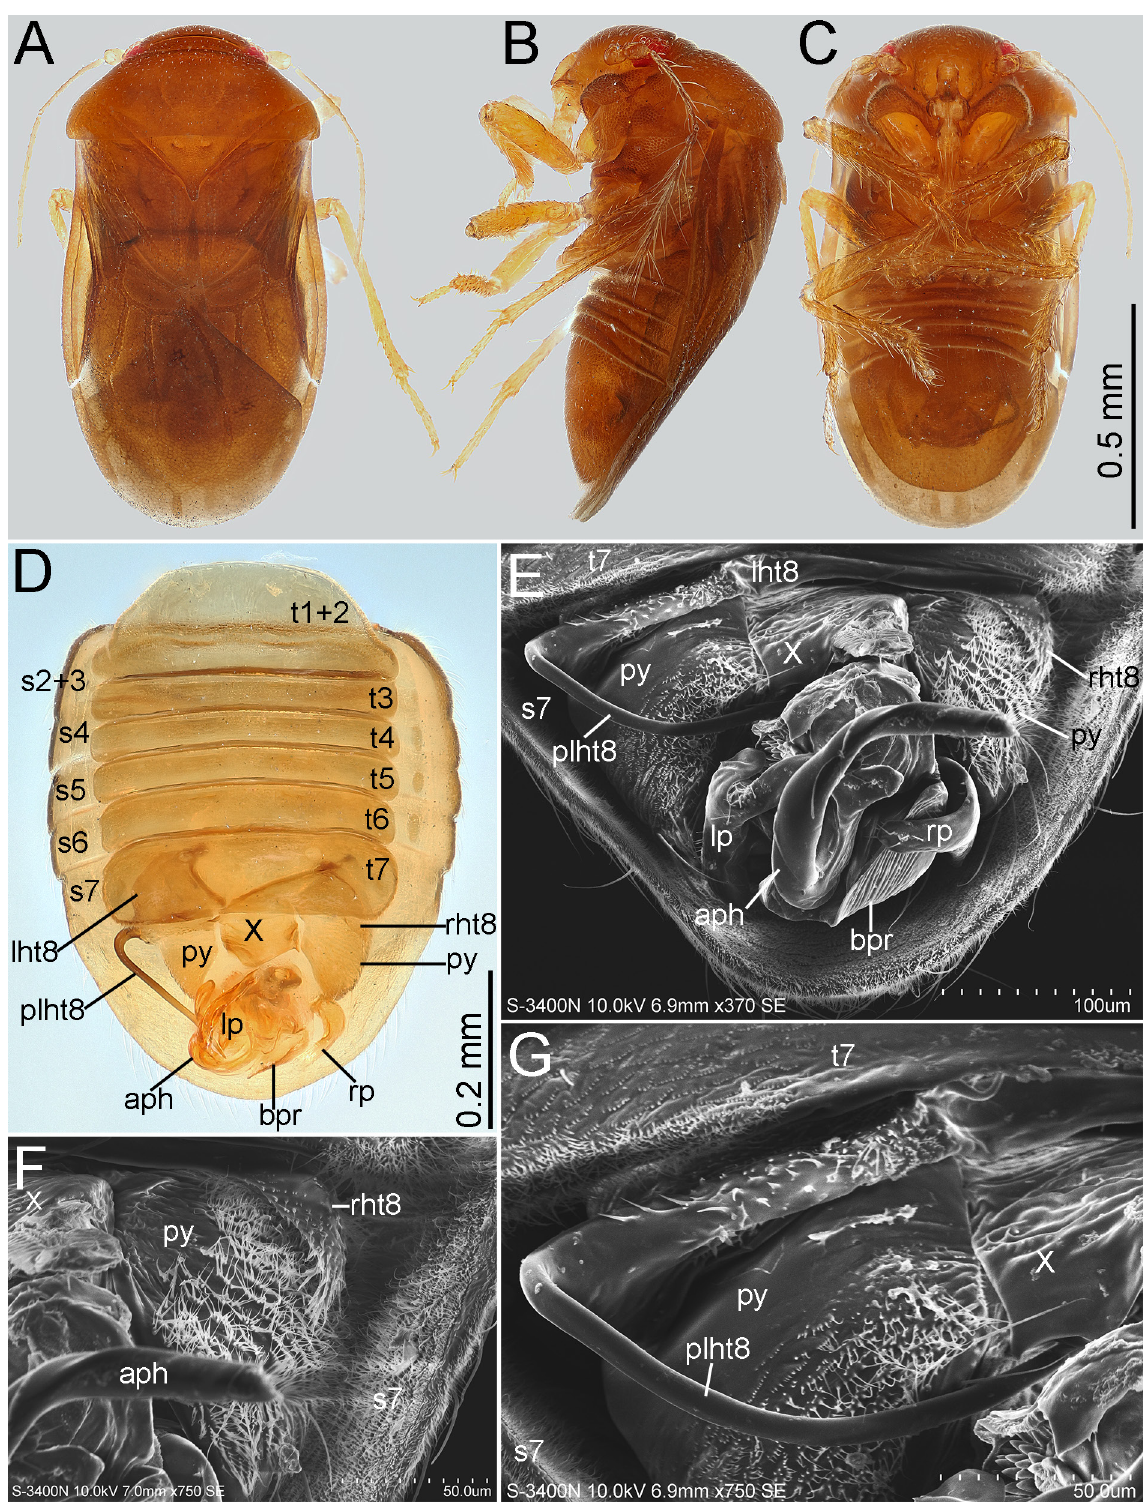
Fig. 15. Kokeshia pengae sp. nov. A‒C . Habitus, holotype, ♂ (SYSBM). A . Dorsal view. B . Lateral view. C . Ventral view. D . Pregenital abdomen and genitalia, dorsal view, paratype, ♂ (SYSBM). E‒G . Scanning electron micrographs of genitalia, paratype, ♂ (SYSBM). E . Dorsal view. F . Right side, dorsal view. G . Left side, dorsal view. Abbreviations: see Material and